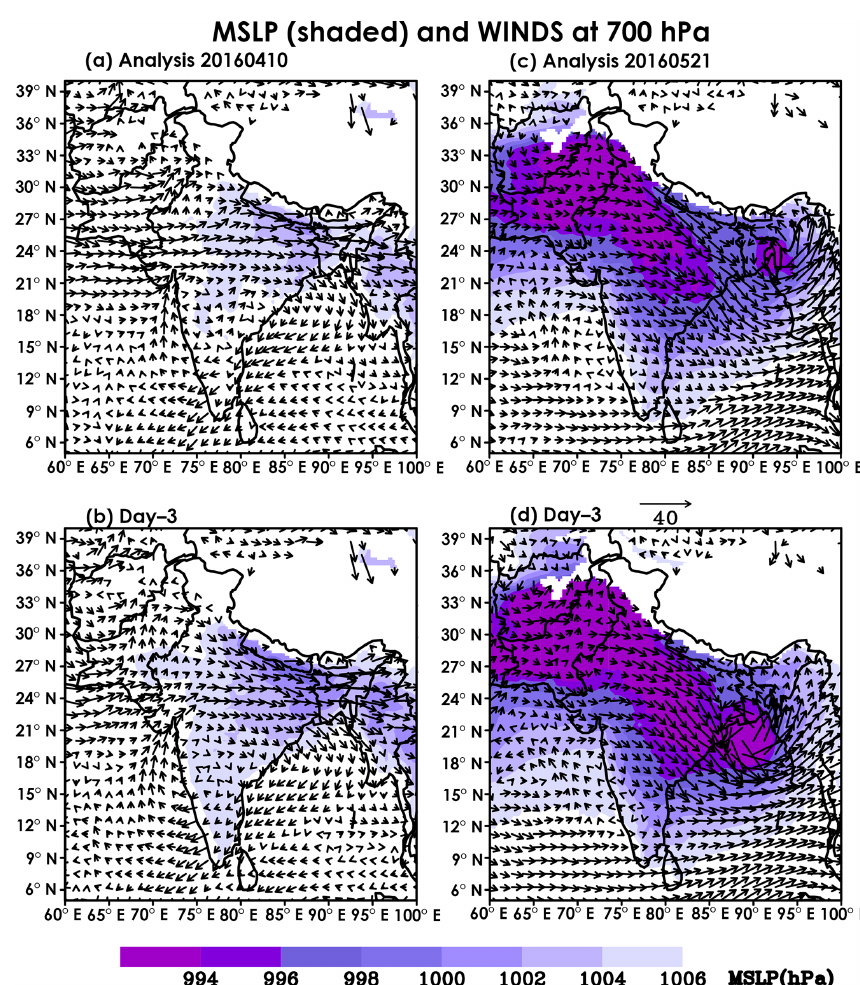
Figure 4. Shaded area shows mean sea level pressure (MSLP) and winds at 700hPa, showing heat low (a) . Analysis of 20160410 (b) day 3 forecast valid for 20160410 (c) . Analysis of 20160521 (d) day 3 forecast valid for 20160521. The analysis and the forecasts are based on the NCMRWF unified model. Both analyses (a, b) and forecasts (c, d) feature dry